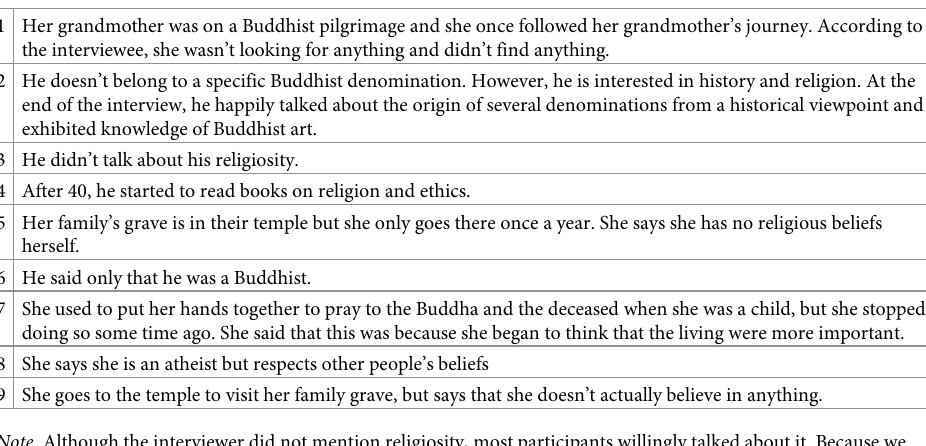
Table 3. Summary of participants’ religiosity disclosed in the